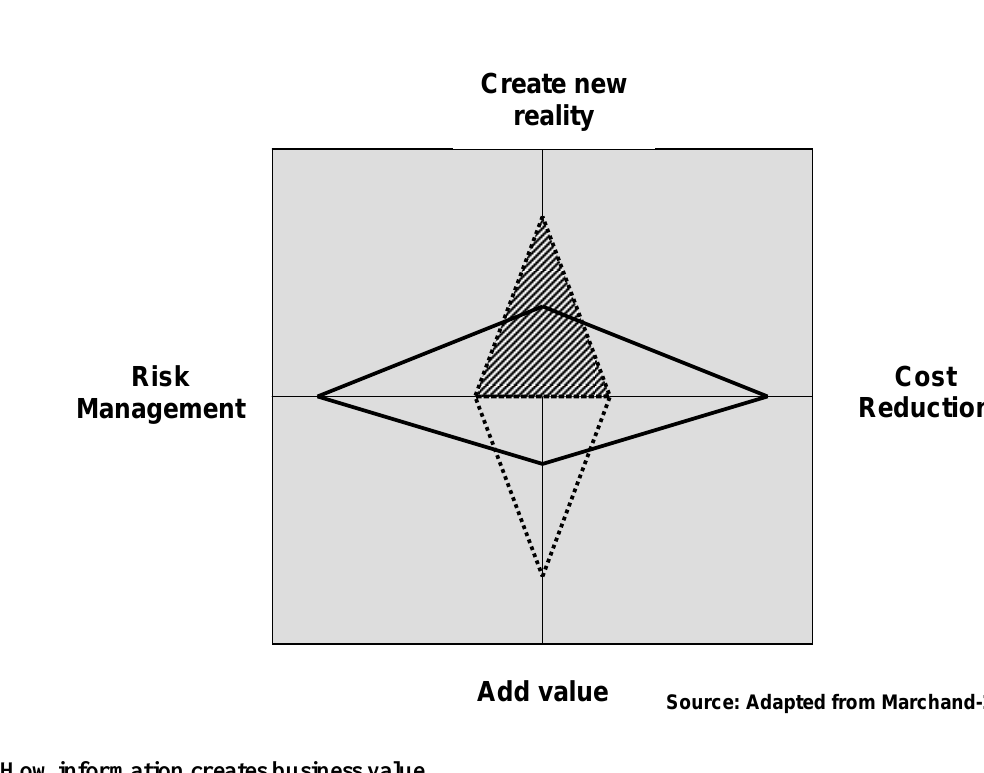
Figure 2: How information creates business value